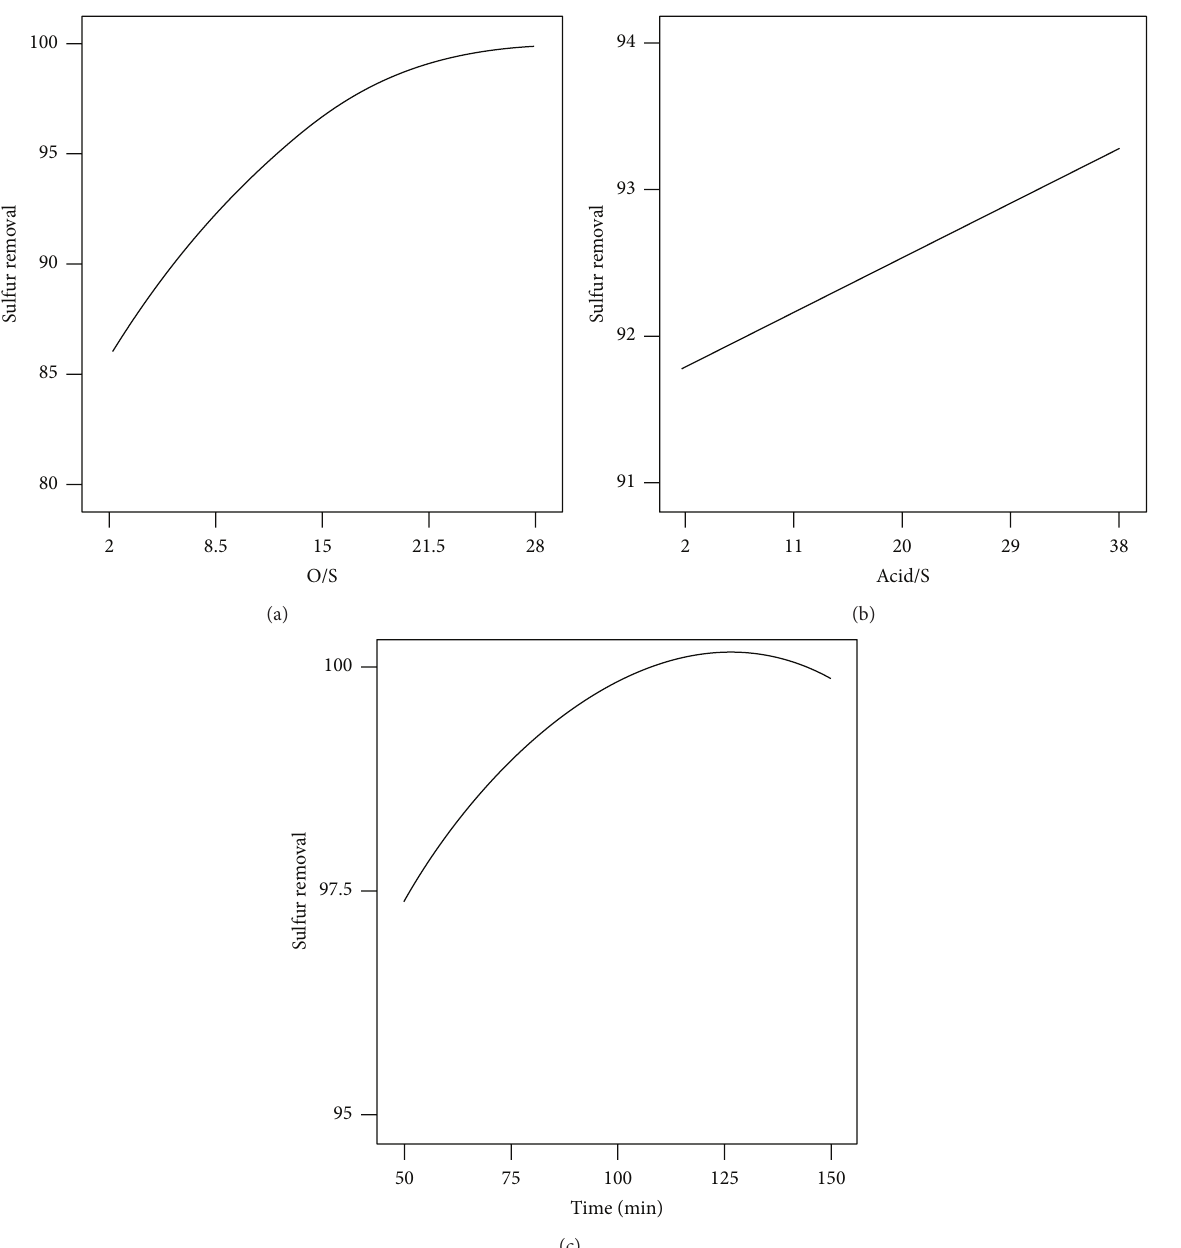
Figure 2: (a) Sulfur removal as a function of O/S, acid/S = 2, and time = 150min. (b) Sulfur removal as a function of acid/S, O/S = 3, and time = 100min. (c) Sulfur removal as a function of time, O/S = 28, and acid/S = 2 (oxidation condition: T = 65 ∘ C; aqueous phase pH = 1.5. Extraction condition: T = 22 ∘ C; solvent-to-oil phase volume ratio = 1; number of extraction stages =